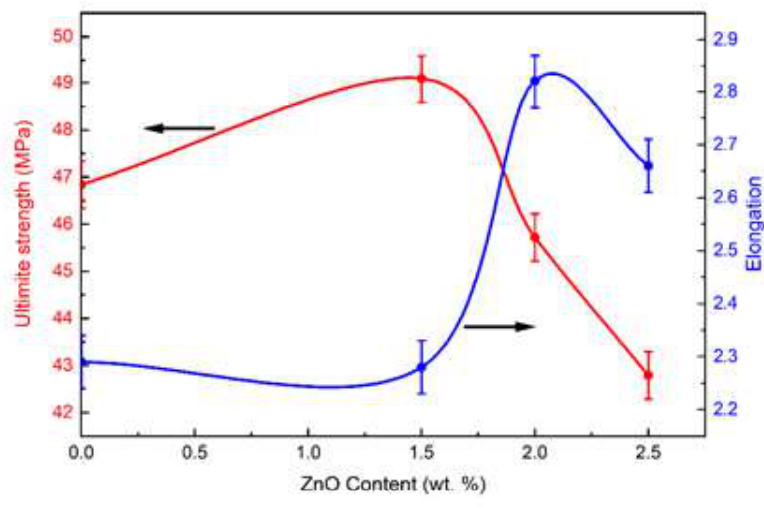
Figure 4: Variation of the ultimate tensile strength and elongation of CA/TiO 2 films with different ZnO